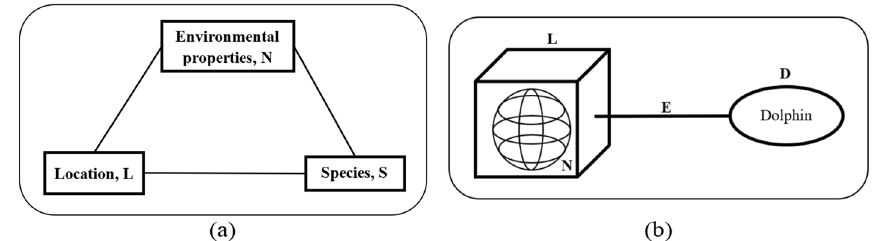
Fig. 8 a Habitat Suitability Triangle (HST) (Source: Liew et al. 2015a, p. 268); b Basic Building Block of the Bipartite Network (Source: Liew et al. 2015a, p.